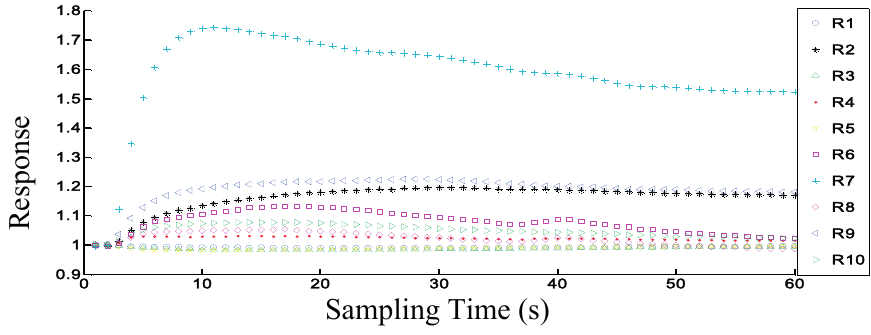
Figure 3. The response of the electronic nose to 30 BRPH adults (where R1–R10 represent the 10 sensors,